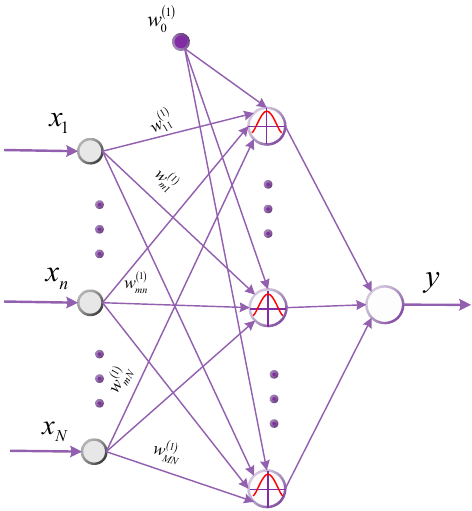
Figure 3. General structures of radial basis function (RBF) network.